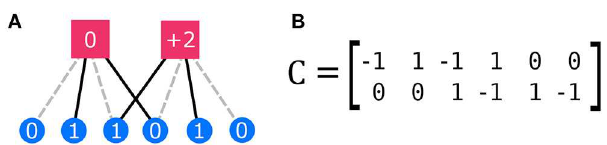
FIGURE 1 | Representation of the agent cognitive-evaluative map, adapted from Banisch and Olbrich [35]. In this example, agents form attitudes on N 2 = different issues, represented by the squares in (A) . Their attitudes are based on their beliefs M 6 facts, represented as circles with ones indicating the = presence of a belief and zeros indicating its absence. Beliefs may contribute positively (black solid lines), or negatively (gray dashed lines) to the attitudes, or may not contribute at all (no line). The mapping from beliefs to attitudes is summarized by the matrix C , shown in (B) . Respectively, 1, 1, and 0 s − represent positive, negative, and null